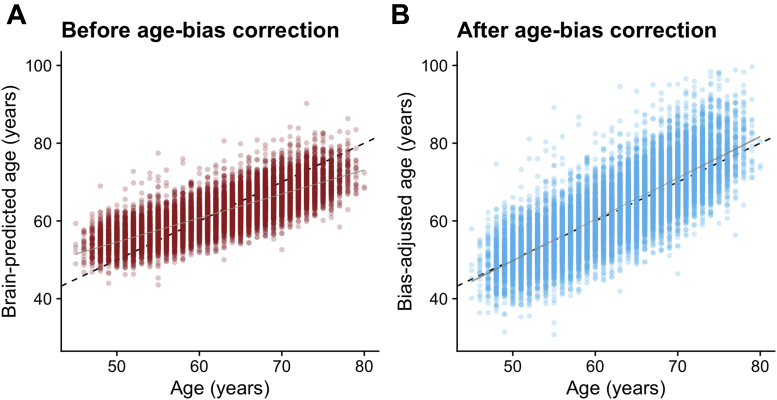
Brain-predicted age by chronological age in the test set, with and without age-bias adjustment. Scatterplots depicting chronological age (x-axis) by brain-predicted age (y-axis) in UK Biobank test set (n = 14,701). Black line is the line of identity. Gray line is the regression line of age on brain-predicted age with shaded areas representing the 95% confidence intervals. A) Brain-predicted age values generated from application of previously trained LASSO regression model. The age bias is evident from the slope of the regression line. B) Brain-predicted age values have been adjusted by the slope and intercept of the age-bias line in the training set.